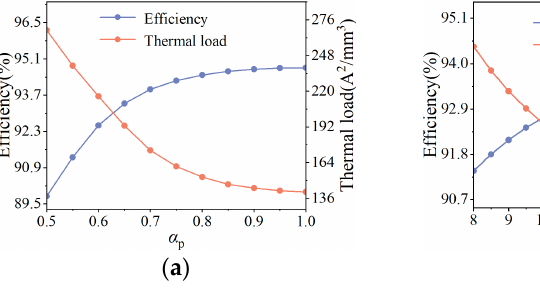
( c ) Figure 4. Influence curves of single factors on efficiency and thermal load. ( a ) Air gap length; ( b ) core length; ( c ) conductors per slot. After the above analysis, the variation ranges of the six optimized design parameters are listed in Table 2. In the analysis, if the pole arc coefficient is too small, then the effi ‐ ciency is low and does not meet the requirements. When the pole arc coefficient ap ‐ proaches 1, the efficiency gradually becomes stable and the change is not large. Consider ‐ ing the cost factor, the variation range of the pole arc coefficient is set as 0.65–0.95. In addition, the PM thickness has the same influence characteristics as the pole arc coeffi ‐ cient. If the PM thickness is too small, then it will not meet the magnetic field require ‐ ments, and if the PM thickness is too large, then the permanent magnet will be wasted. Therefore, the PM thickness variation range is limited to 10–15 mm. In the optimization, limited by the installation size, the rotor outer diameter is fixed. When the rotor outer diameter and the slot size remain unchanged, the core may be saturated with the change in the stator outer diameter. In order to avoid this situation, the optimization range of stator outer diameter is limited between 840 mm and 880 mm. T o obtain a suitable back EMF, the variation range of the core length is set from 900 mm to 940 mm. Due to the